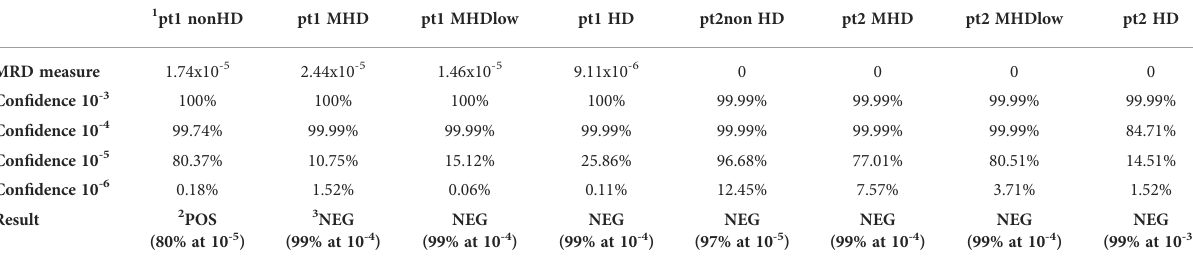
TABLE 5 MRD evaluation in hemodiluted BM samples. NGS-basedMRDmeasurementsfor two MMpatients (pt) whoseBMsamples wereprogressively dilutedwithPB,toobtain4different cases:nonHD,MHD, MHDlow,andHD.MRD measures arequanti fi edby the LymphoTrack ® MRDSoftware( In vivo scribeInc, SanDiego,CA,USA).Inbold:Results areanestimateofthe clonalfrequency oftheprevalent rearrangement(s)detectedatdiagnosis.Foreach sensitivity levelindicated,thestatisticalcon fi